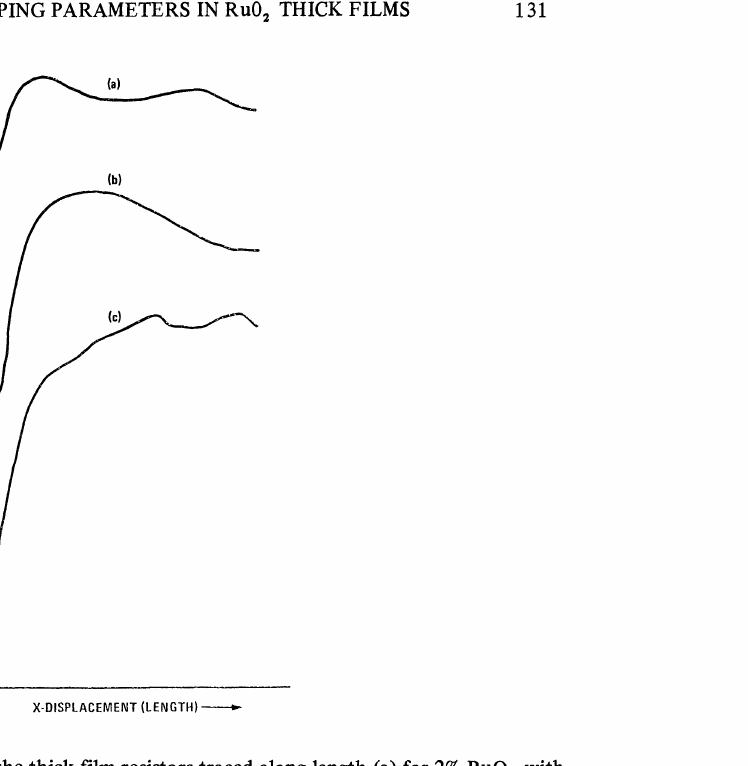
The thickness profile of the thick f’tim resistors traced along length (a) for 2% RuO with 0.3 size; (b) for 2% RuOa with 3.1 size; (c) for 12% RuOa with 3.1 size.